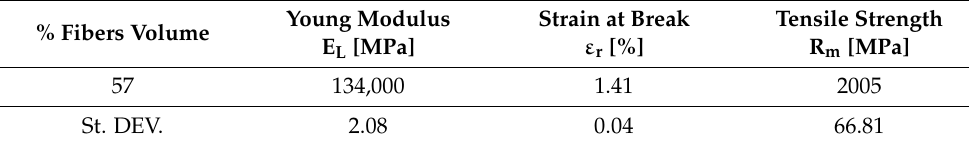
Table 1. Characteristics of the composite laminate.